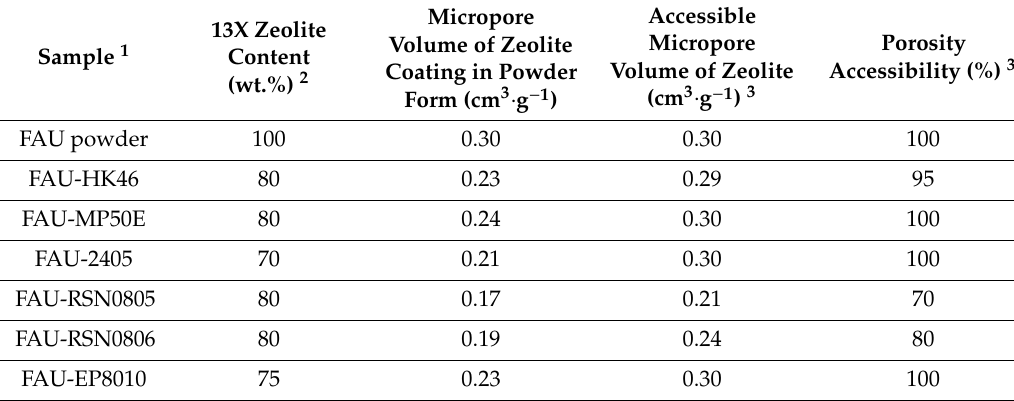
Figure 5. Nitrogen adsorption-desorption isotherms of pure 13X powder and zeolite coatings. Table 4. Micropore volumes and porosity accessibility of pure 13X zeolite and zeolite coatings determined from nitrogen adsorption-desorption isotherms at − 196 °C.